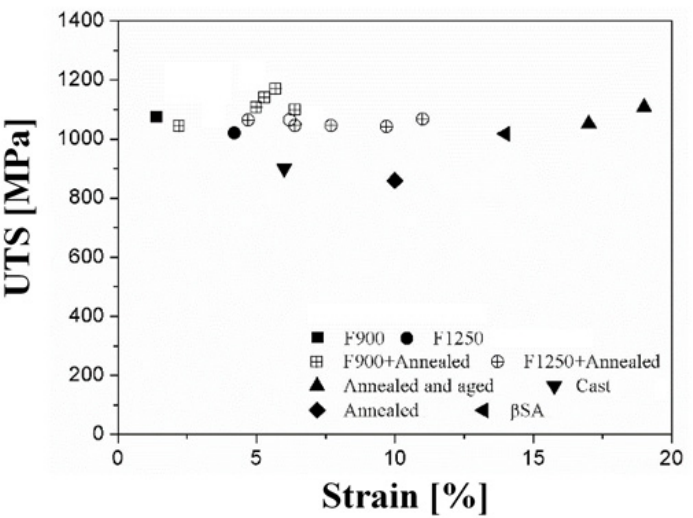
Figure 5. Comparison of the mechanical properties of the forged and annealed Ti-5Al-2.5Fe alloy, data from [12,28].